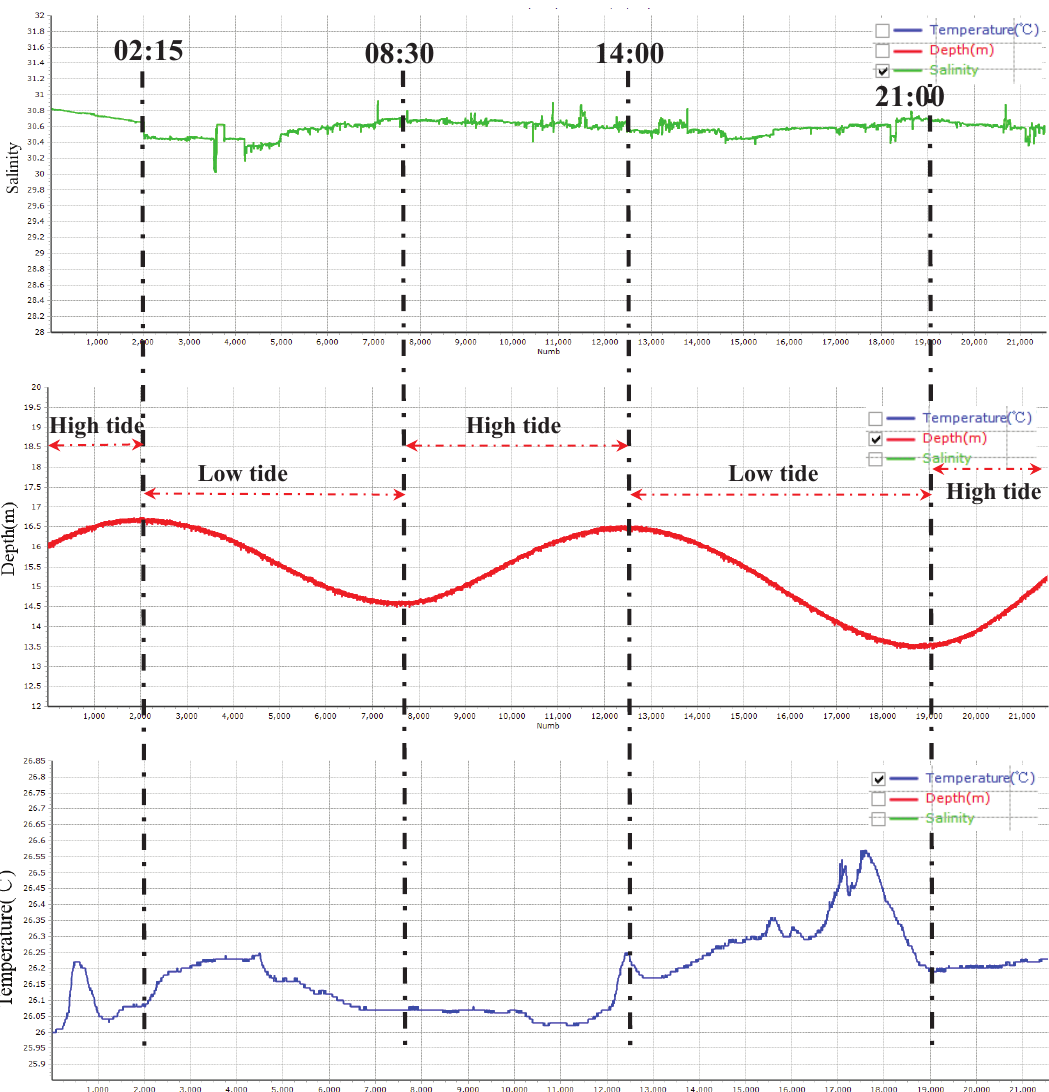
Figure 17. The daily variation curves of temperature, salinity and depth on 19 August